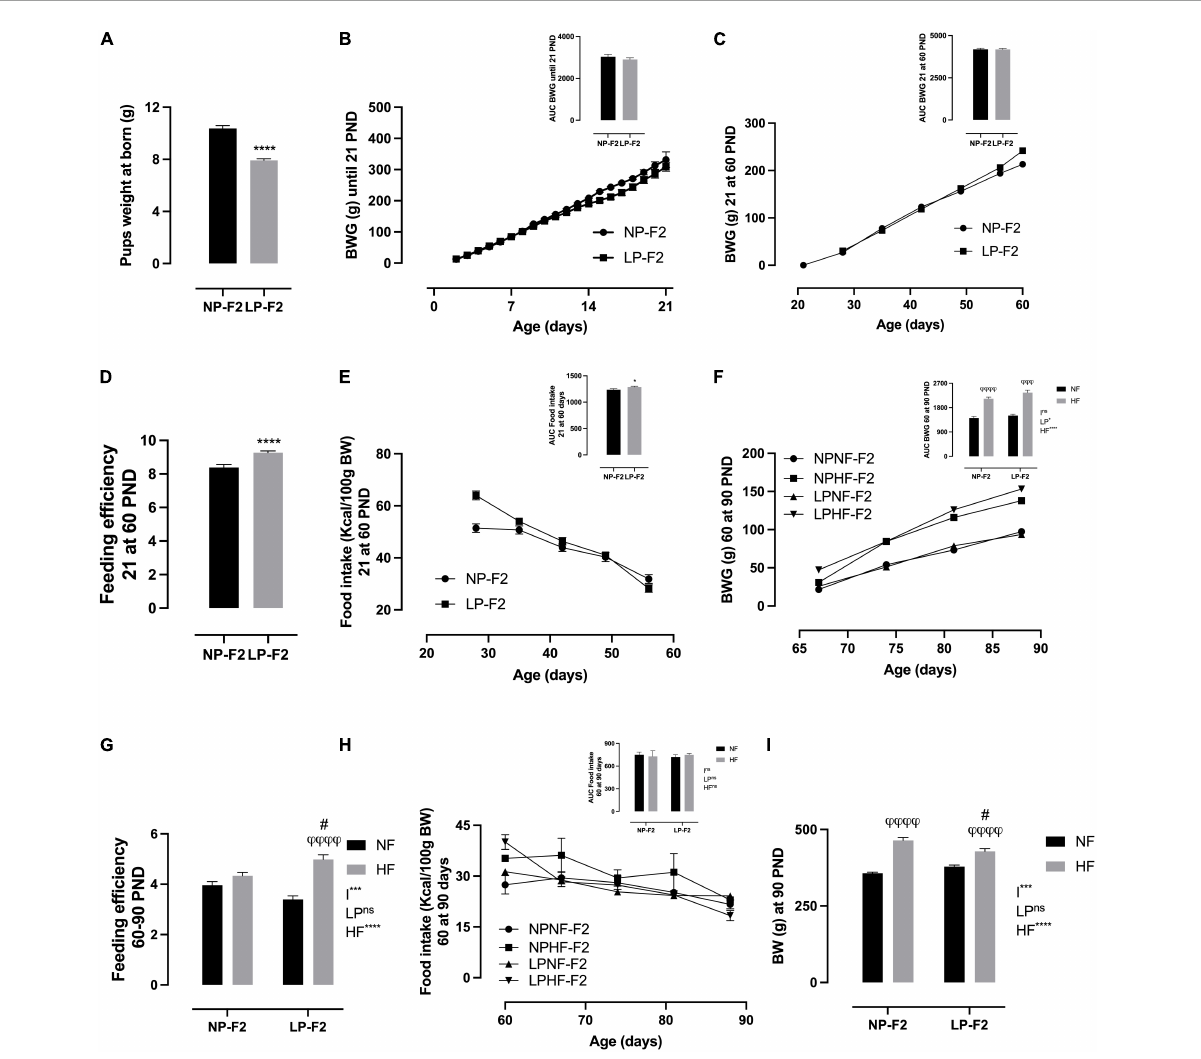
FIGURE3 Offspring’s biometric parameters, caloric intake, and feeding efficiency. Litter weight at born (A) , body weight gain during lactation (B) , body weight gain from 21 to 60 PND (C) , feeding efficiency from 21 to 60 PND (D) , food intake from 21 to 60 PND (E) , body weight gain from 60 to 90 PND (F) , feeding efficiency from 60 to 90 PND (G) , food intake from 60 to 90 PND (H) , and body weight at 90 PND (I) . The data are expressed as the means ± S.E.M. and were obtained from 12 to 15 rats of each group (from 4 to 5 different litters). The inset represents the AUC. * p < 0.05, **** p < 0.0001 for Student’s t -test. # p < 0.05, ## p < 0.01, ### p < 0.001, #### p < 0.0001 to NP-F2 vs. LP-F2 in the same conditions; ϕ p < 0.05, ϕϕ p < 0.01, ϕϕϕ p < 0.001, ϕϕϕϕ p < 0.0001 to NF vs. HF in the same group for the probability based on the Tukey’s post hoc analysis. LP, low-protein diet factor; HF, high-fat diet factor; and I, interaction between LP and HF factors. * p < 0.05, *** p < 0.001, **** p < 0.0001, and ns, no significant difference, based on two-way analysis of